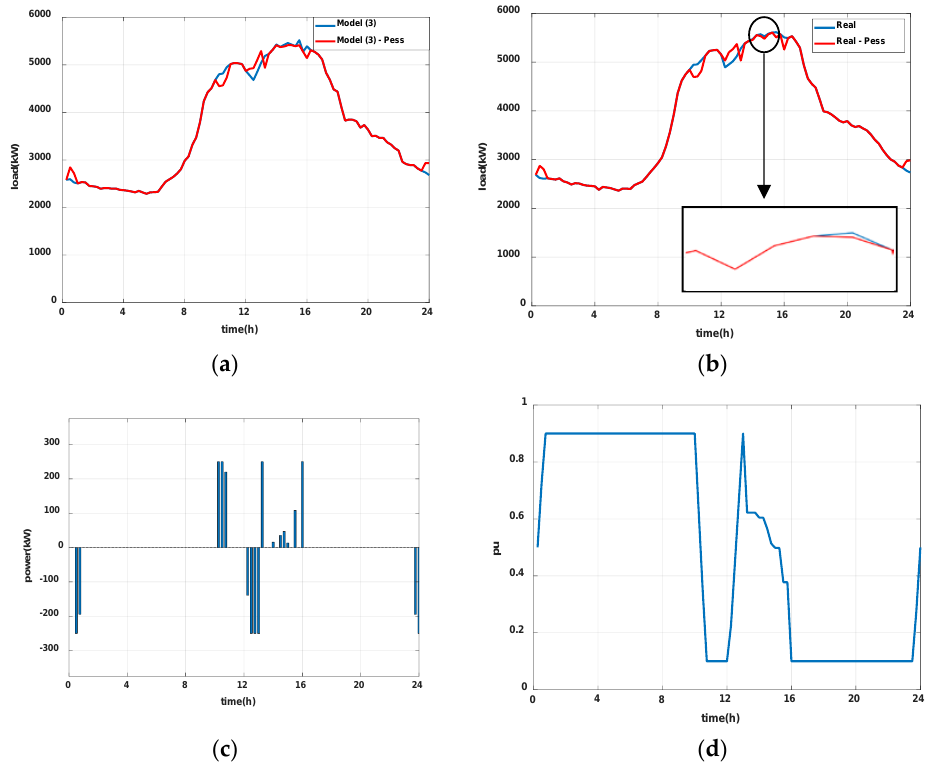
Figure 10. Case 4 simulation results. ( a ) Comparison between the predicted load and the recorded load after applying the two-stage algorithm; ( b ) comparison between the actual load and the recorded load after applying the two-stage algorithm; ( c ) ESS power; and ( d ) SOC.